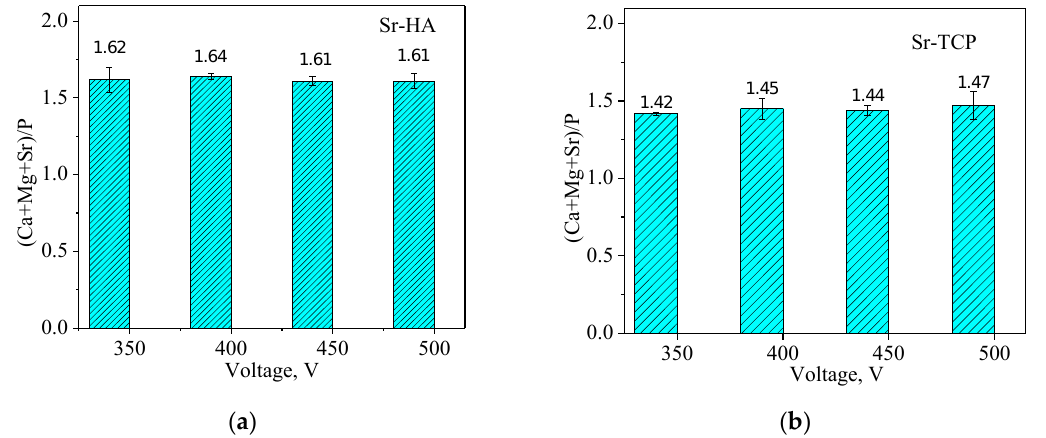
(Table 1). The quantity of strontium in the coatings deposited at the voltages from 350 to 500 V varied in the range of 1.64–1.93 at.%.